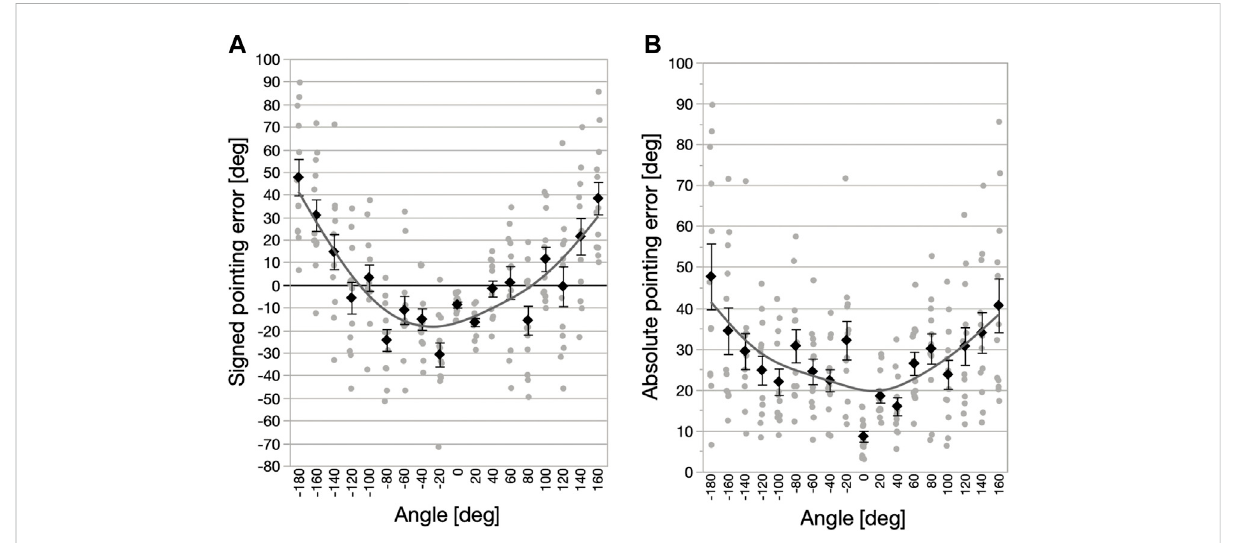
FIGURE 4 Means and standard errors of signed (A) and absolute pointing errors (B) in study 1. Gray dots depict individual participant ’ s